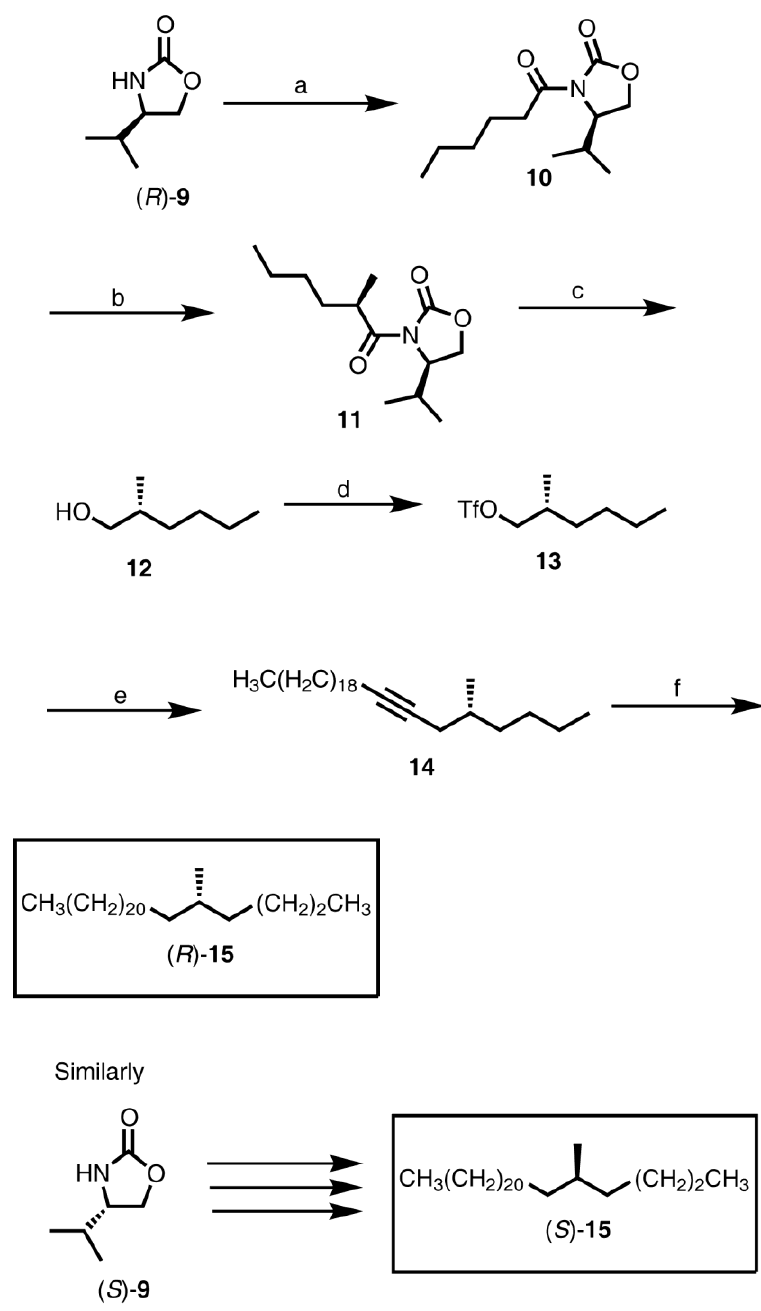
Figure 2. Synthesis of ( R )- and ( S )-5-methylheptacosane ( 15 ). Reagents: ( a ) i. n- BuLi, THF; ii. CH (CH ) COCl (96%); ( b ) i. NaHMDS, THF; ii. MeI (94%); ( c ) LiBH 3 2 4 (92%); ( d ) Tf O, pyridine, CH Cl (quantitative for 7 ); ( e ) heneicosynyl lithium, THF 2 2 2 (76% (cid:177) 80%); ( f ) H (1 atm), 5% Rh/C, hexane (96% (cid:177) 97%). 2